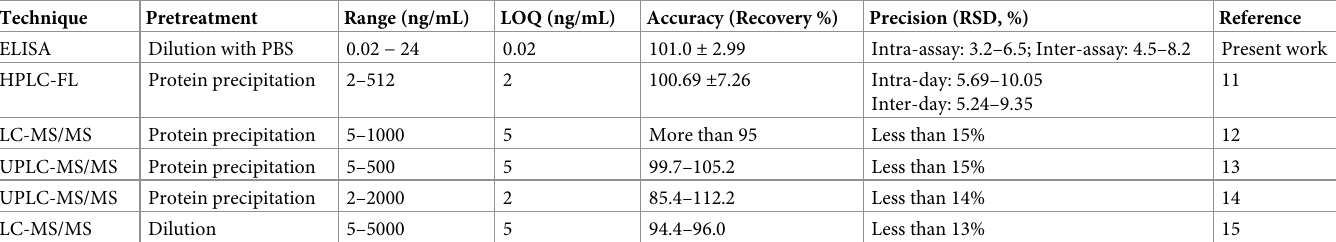
Table 6. Comparison of ELISA with liquid chromatographic techniques for analysis of CZT in human